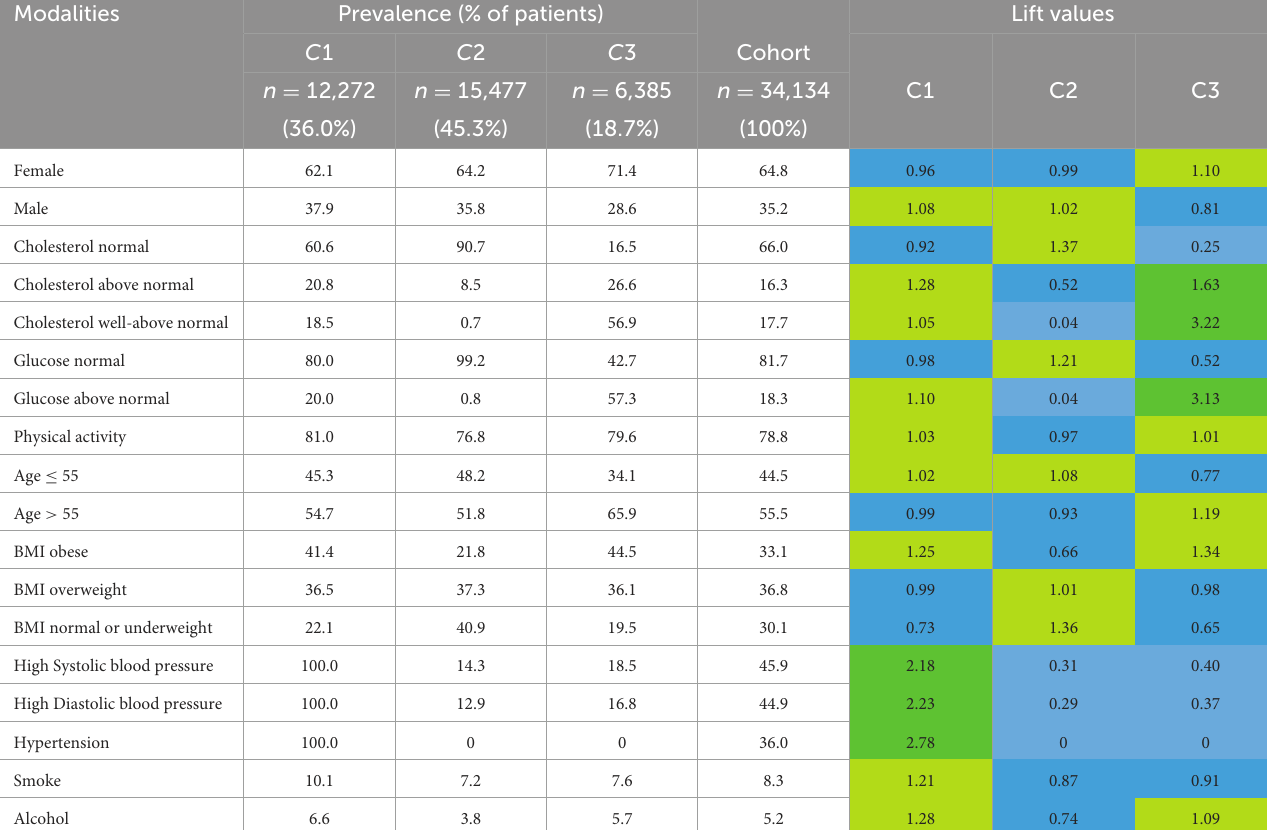
TABLE 3 Prevalence and lift values of each modality and by cluster.